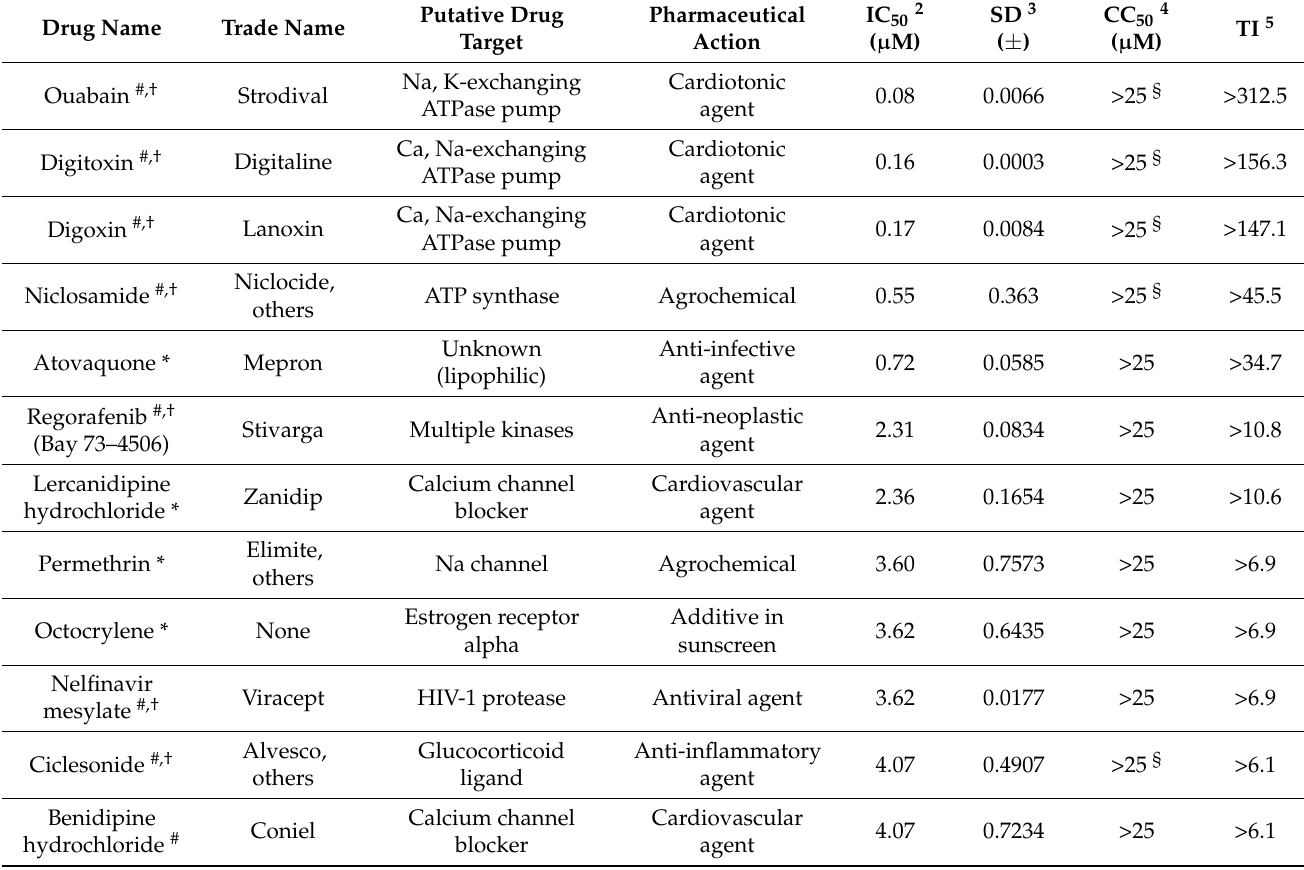
Table 3. Hit profiling and anti-MERS-CoV efficacies of FDA-approved drugs in Vero cells 1 .